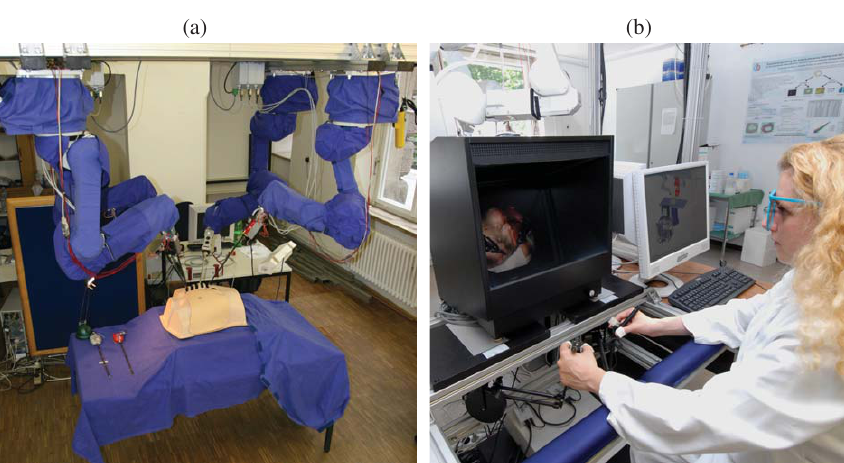
Fig. 1. Hardware setup: Four ceiling mounted robots with surgical instruments, either a stereoscopic endoscope or different surgical micro- grippers. The minimally invasive instruments are augmented with force sensors. In-/output is accomplished at a master console, comprising two force feedback devices. Visual feedback is accomplished by a 3D-display with polarization